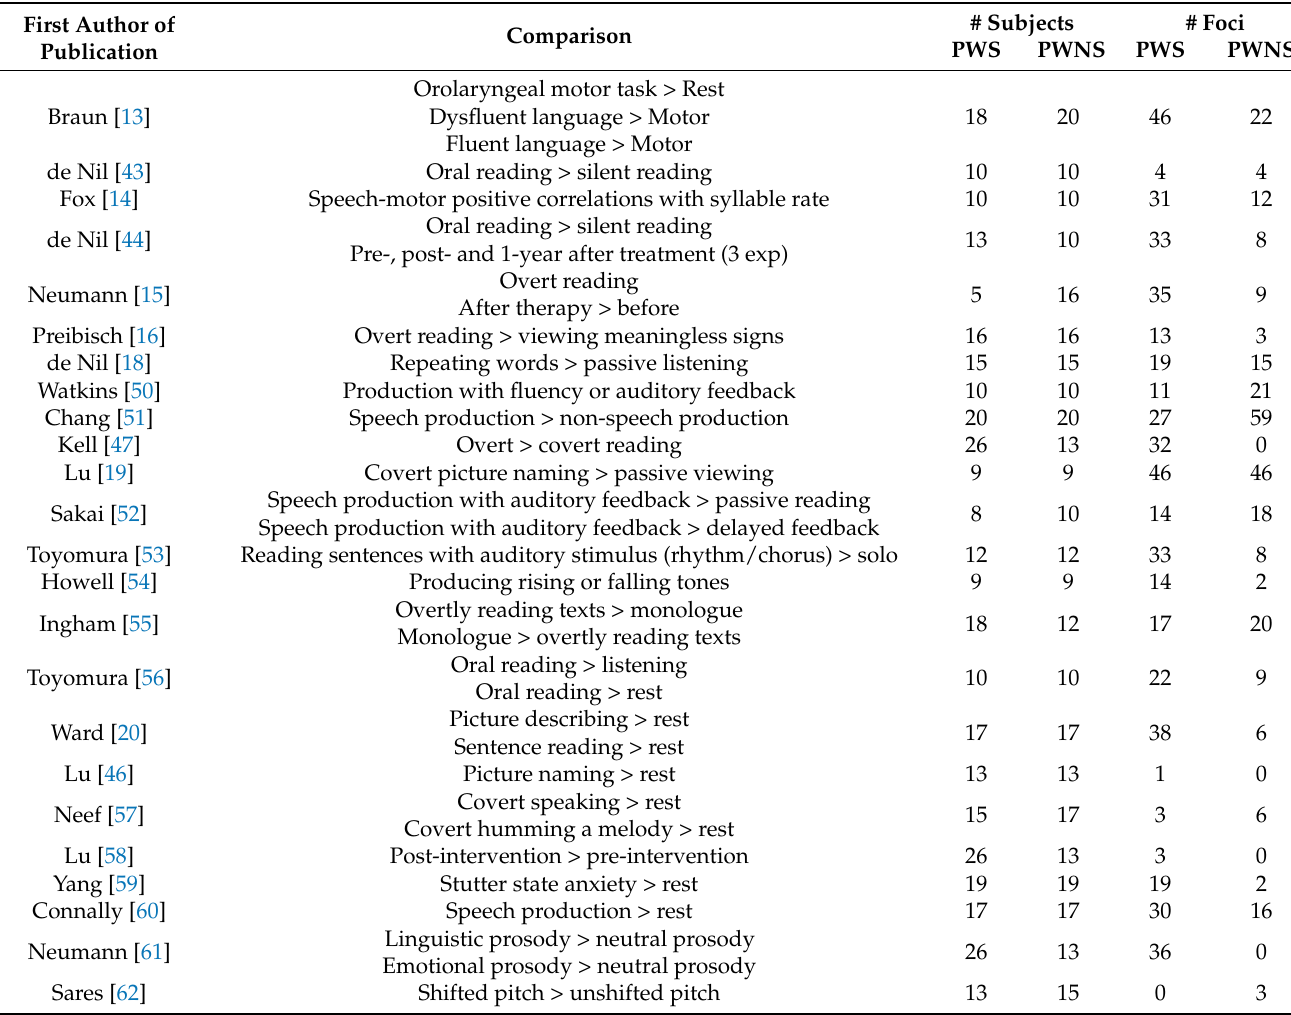
Table 1. Details of experiments included in the ALE analysis of PWS and PWNS